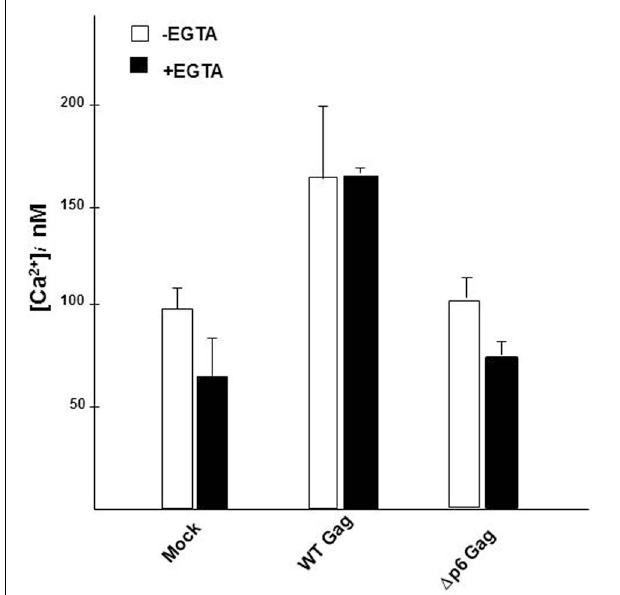
FIGURE 2 | Gag expression induced elevation of cytosolic Ca 2 + concentration. Mock-transfected cultures of COS cells or cultures transfected with WT Gag or (cid:2) p6 Gag were assayed for Ca 2 + in the absence ( open symbol ) or presence ( filled symbol ) of EGTA. Each bar represents the average value determined for [Ca 2 + ] i in 3 independent trials using triplicate samples. In each trial, [Ca 2 + ] i was assayed every 6s over a 2min period. The standard error of the mean was ± 3% for the mock-treated samples and ± 5% for the gag -transfected